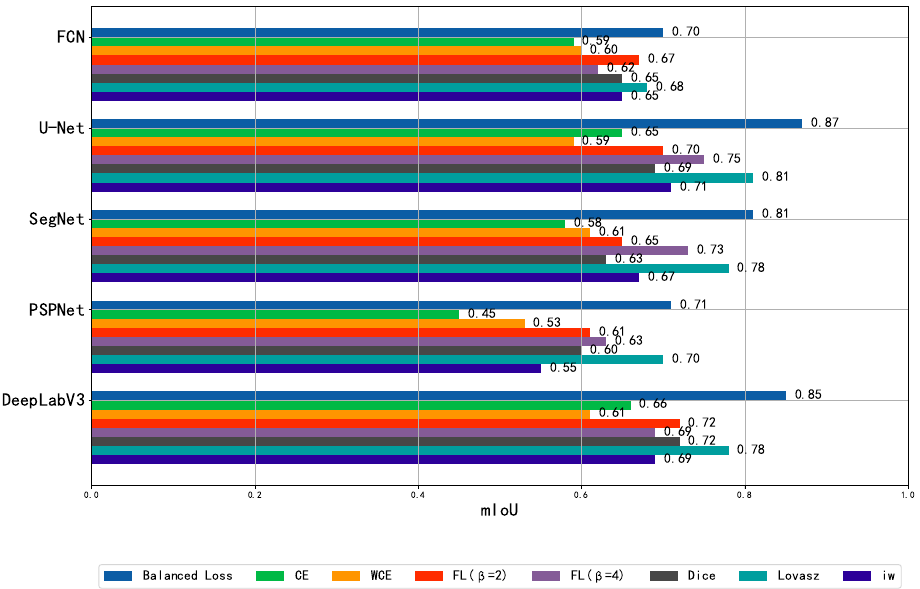
Figure 9. Mean IoU comparison of the balanced loss function and other loss functions on various networks trained on